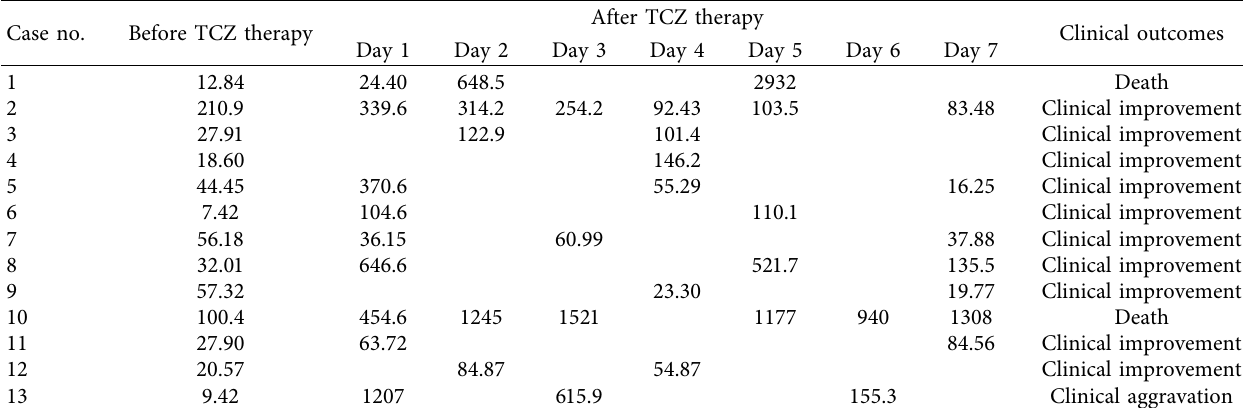
Table 2: The IL-6 levels of COVID-19 patients before and after TCZ treatment (pg/mL). Case